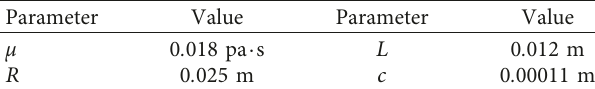
Table 2: Values of the parameters for oil film bearing. Parameter